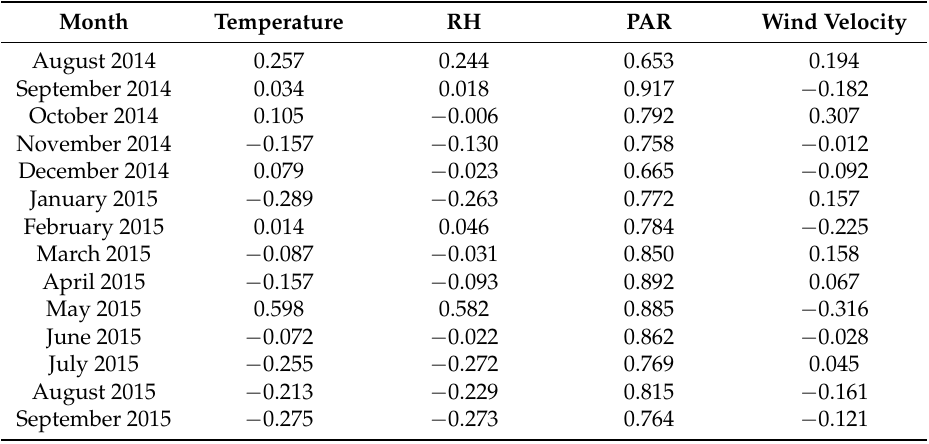
Table 3. Partial correlation coefficients between the urban lawn ET and air temperature, relative humidity (RH), PAR, and wind velocity in different months over the experimental